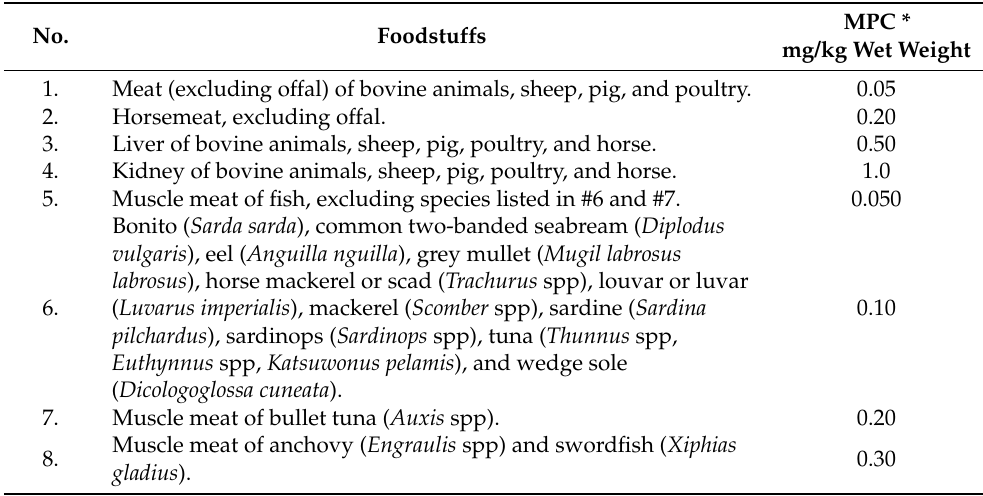
Table 1. Maximum permissible concentrations for cadmium in